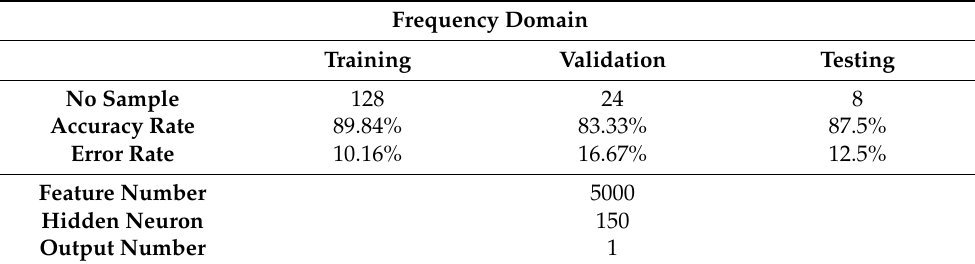
Table 10. Frequency domain ELM classification